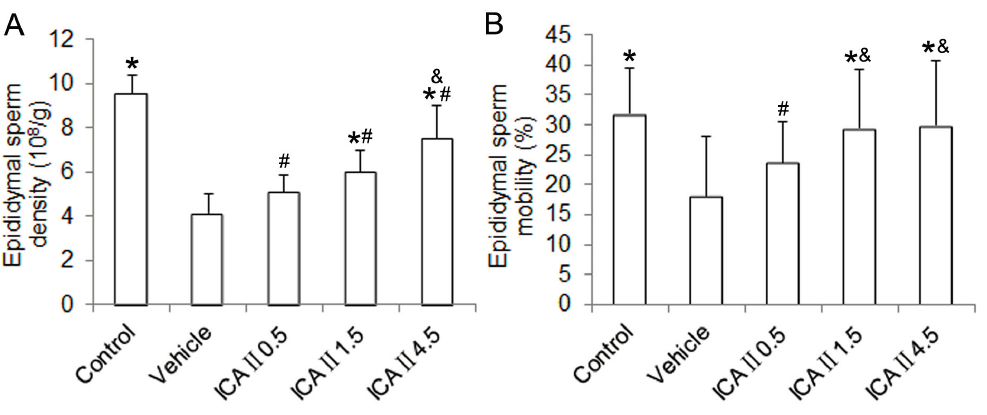
Figure 1. Effect of ICAIItreatment on the epididymal sperm parameters. ( A ) epididymal sperm density; ( B ) epididymal sperm mobility. * p < 0.05 compared with the vehicle group; # p < 0.05 compared with the control group; & p < 0.05 compared with the ICAII1.5